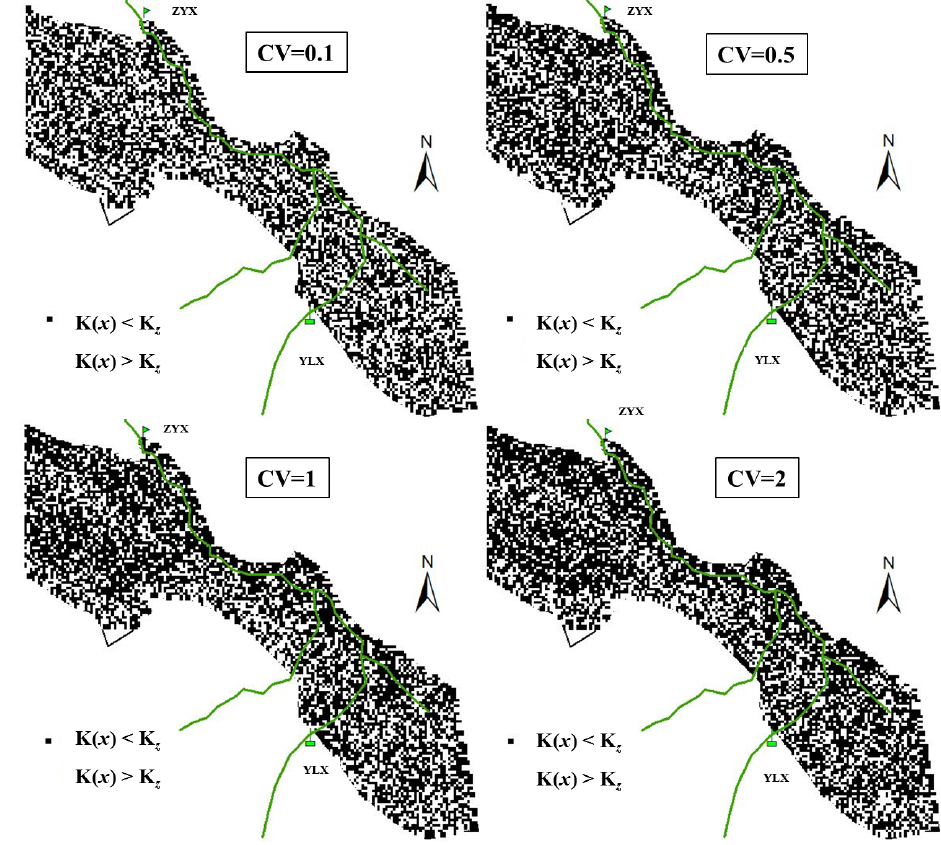
Figure 9. Grid-scale K(x) field map for CV equaling to 0.1, 0.5, 1 and 2.